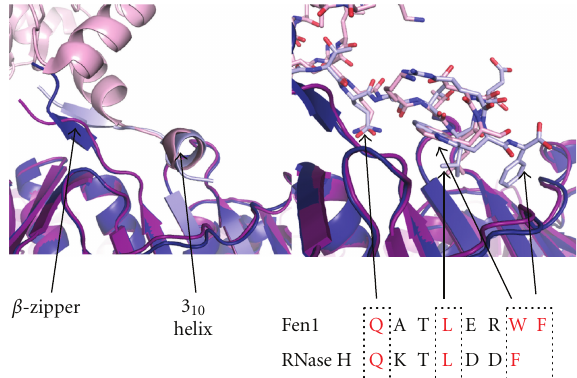
Figure 5: Detailed comparison of the PIP-box interactions of AfuPCNA with a Fen1 peptide (1RXZ) and RNase H (3P83) [12, 15]. The left hand panel depicts the binding partners in cartoon representation and the right hand panel in stick form. The Fen1 complex is shown in light/dark blue and the RNase H complex in pink/purple. Key features and conserved residues in the PIP-box are